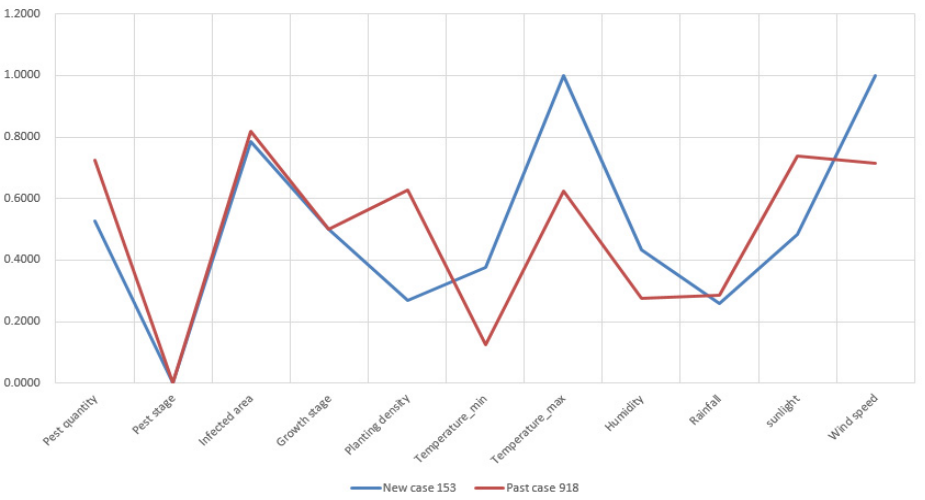
Figure A7. Attribute visualization of new case 152 and retrieved past case 700.